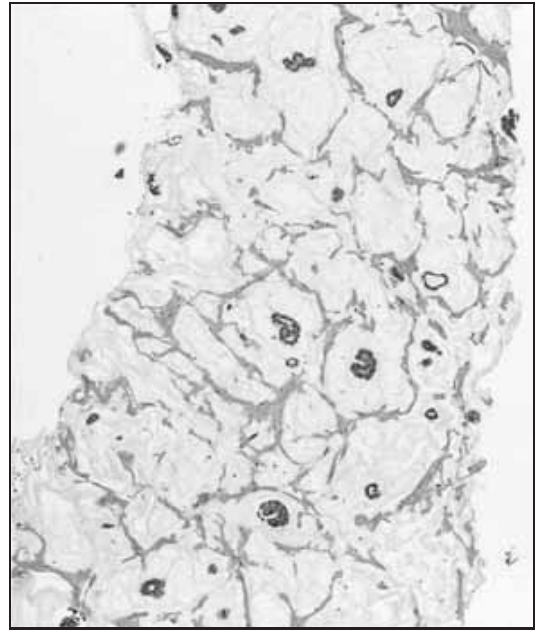
Figura A – Exemplo de carcinoma mucinoso invasor da mama diagnosticado em BAG. Observe o abundante muco extracelular permeando pequenos agrupamentos de células neoplásicas (HE, 100×) BAG: biópsia por agulha grossa; HE: hematoxilina e eosina.